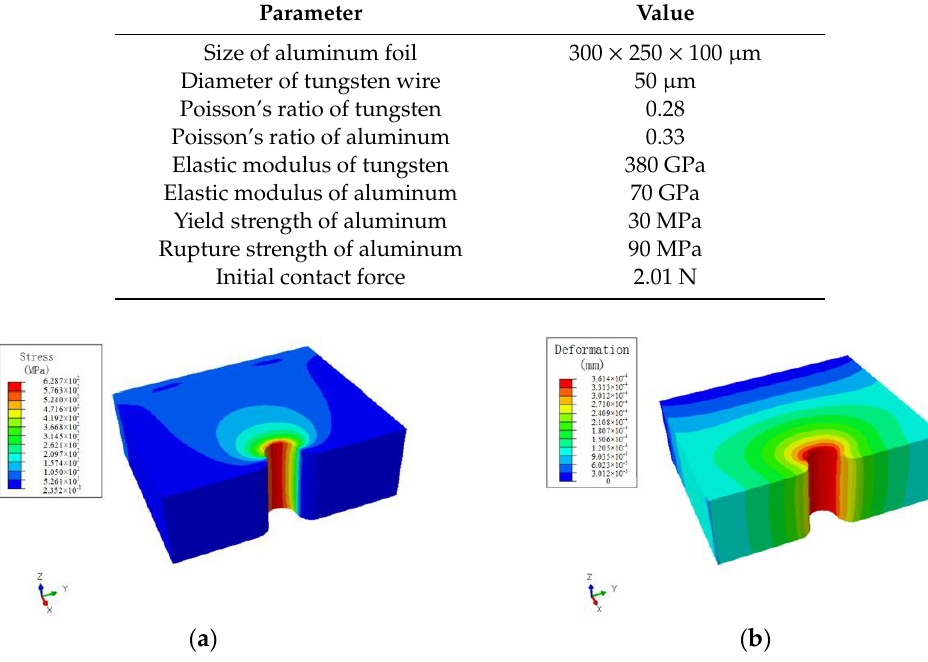
Figure 3. Simulation result: ( a ) stress; ( b ) deformation.